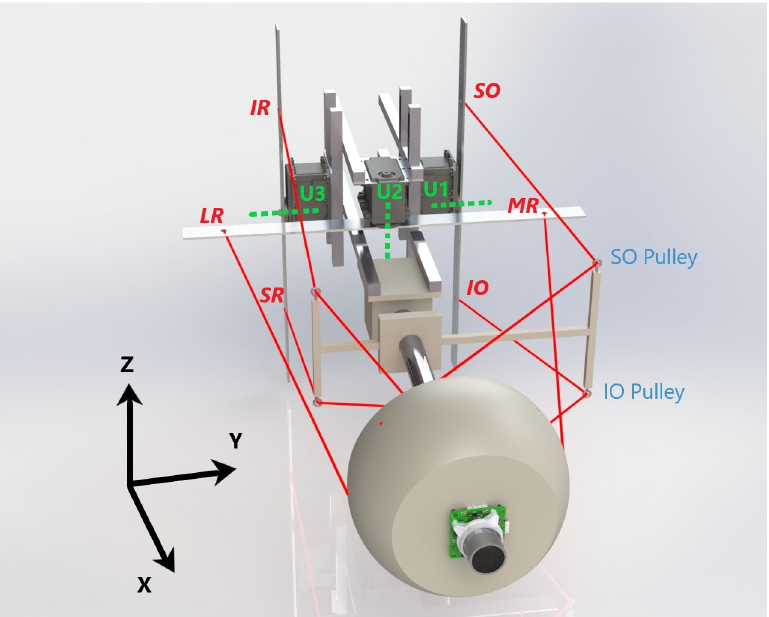
Fig 2. Mechanical robotic system that serves as a biomimetic prototype for the human eye in Fig 1. The scaled eye represented by the spherical segment (7 cm radius) with a camera in the front is driven by elastic tendons (in red) that correspond to the six extra-ocular muscles shown in Fig 1. Each pair of muscles are connected to attachment points on metal rods fixed to the motors(U1-U3), with the rotation axes shown by the green dotted lines. The SO,IO,IR and SR muscles pass through fixed pulleys between the attachment points on the eye and the motor rods to adjust their pulling directions.